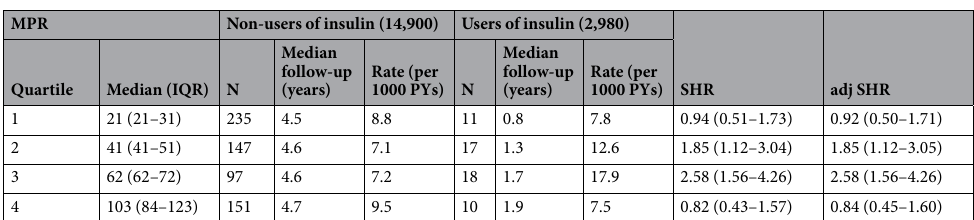
Table 3. Fracture incidence among users of any insulin (N = 2,980) vs matched non-users (N = 24,900), stratified by quartiles of insulin medication possession ratio (MPR) within first year of first insulin use. Only the first insulin use considered (i.e. switching types was not accounted for), then censored. All analyses include incident insulin use as a time dependent covariate. Analyses are PS matched, on a 5:1 ratio of non-users to users in a separate model from the main analysis. Adjusted analyses control for outstanding confounders (P < 0.1) and for propensity score. Abbreviations: N (number of fractures), Interquartile range (IQR), person-years (PYs), subhazard ratio (SHR), adjusted